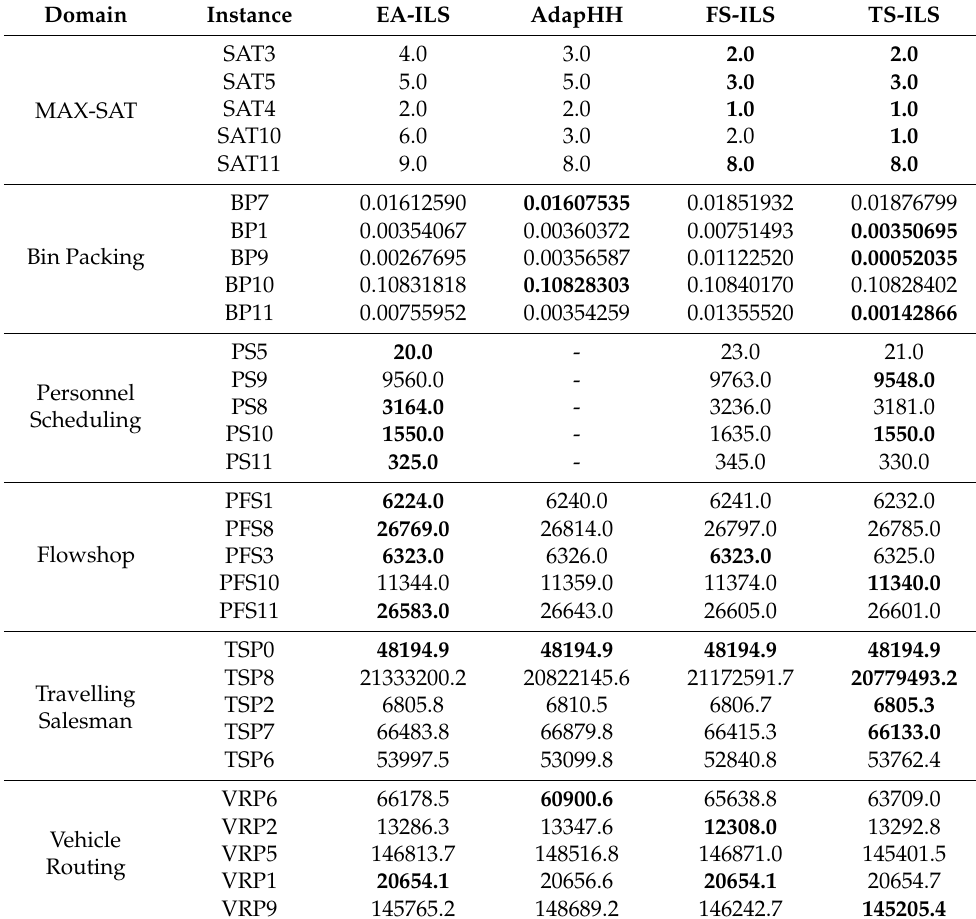
Table 11. Median ofvs Obtained by EA-ILS against three state-of-the-art